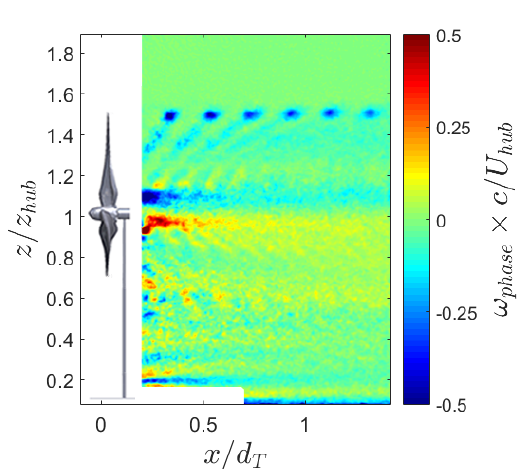
= ∇ × u where u is phase phase phase